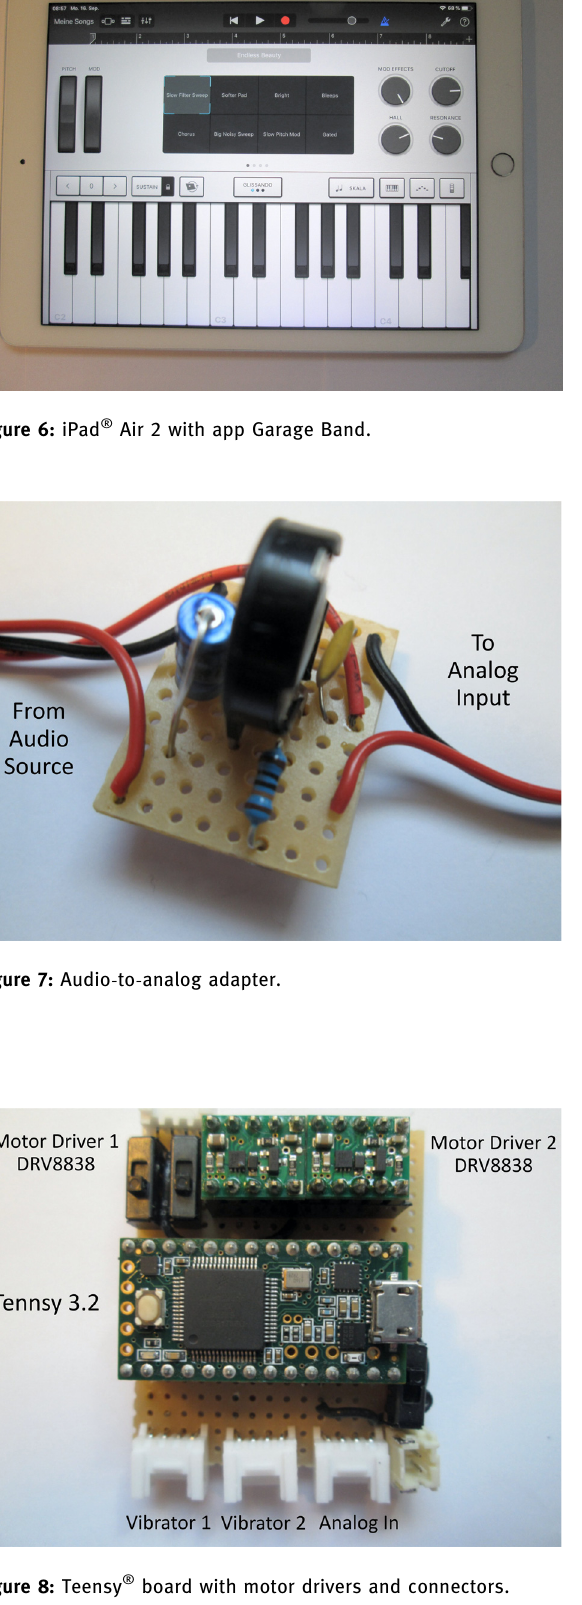
Figure 8: Teensy ® board with motor drivers and connectors.